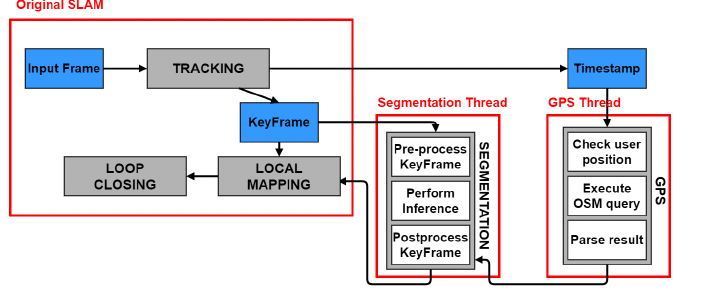
Figure 1. EnvSLAM workflow: On the left, a simplified scheme of ORB-SLAM2 is depicted (the com- plete workflow can be seen in the original paper [20]), while on the right, the additional segmentation and GPS threads, along with their main operations, are